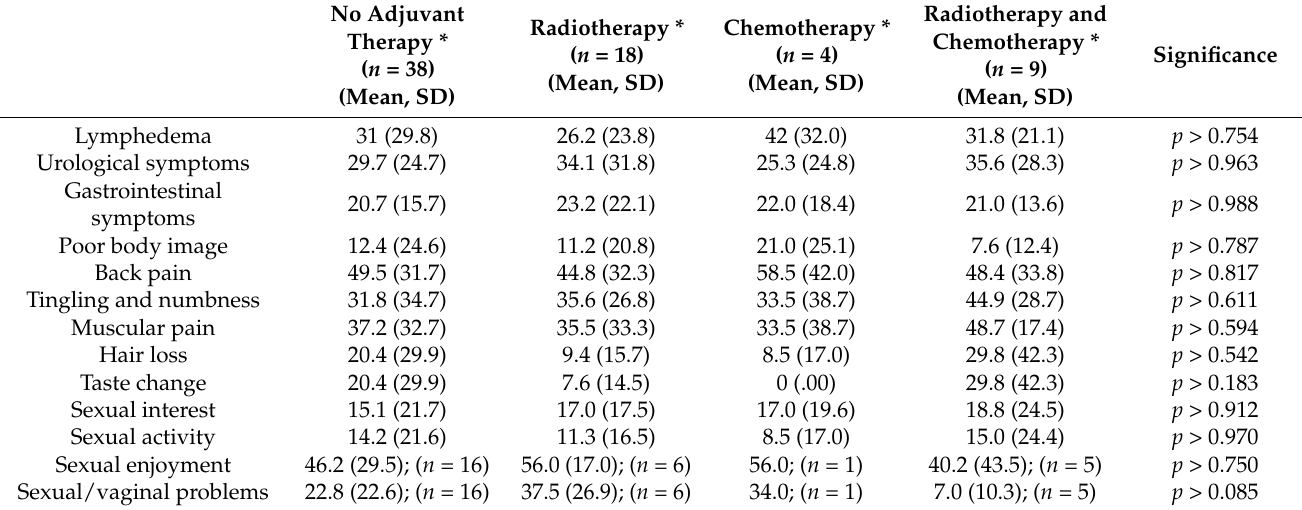
Table 2. Impact of systemic therapy on patient-reported